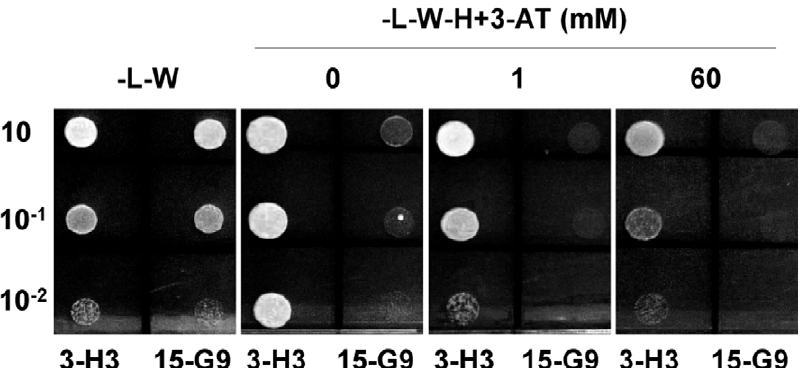
Figure 3. Yeast one hybrid screening with the LIP1-pTUY1H construct. Growth of diploid cells at different concentrations of 3-AT from clones showing positive (3-H3) and negative (15-G9) interactions in the screening. Three serial dilutions of diploid cells from saturated cultures were plated.